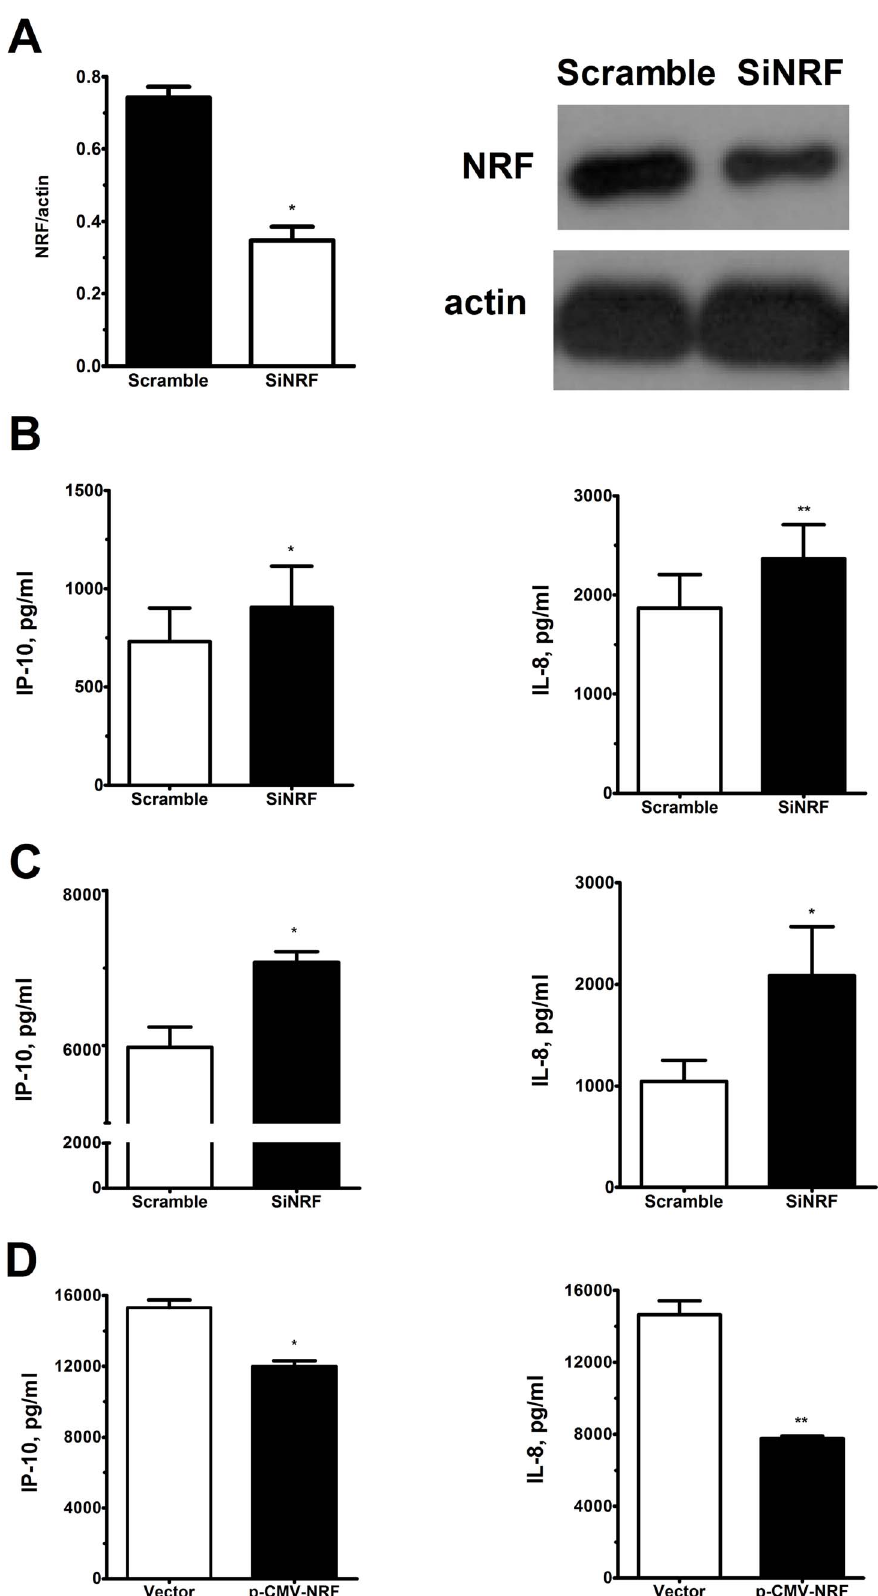
Figure 6. Inhibition of NRF increased the release of IP-10/CXCL10 and IL-8/CXCL8 from PBMC of TB patients. (A) Transfection with siRNA targeting NRF (SiNRF) or scramble control (Scramble) for 48 hours significantly decreased the expression of NRF protein in PBMCs of TB